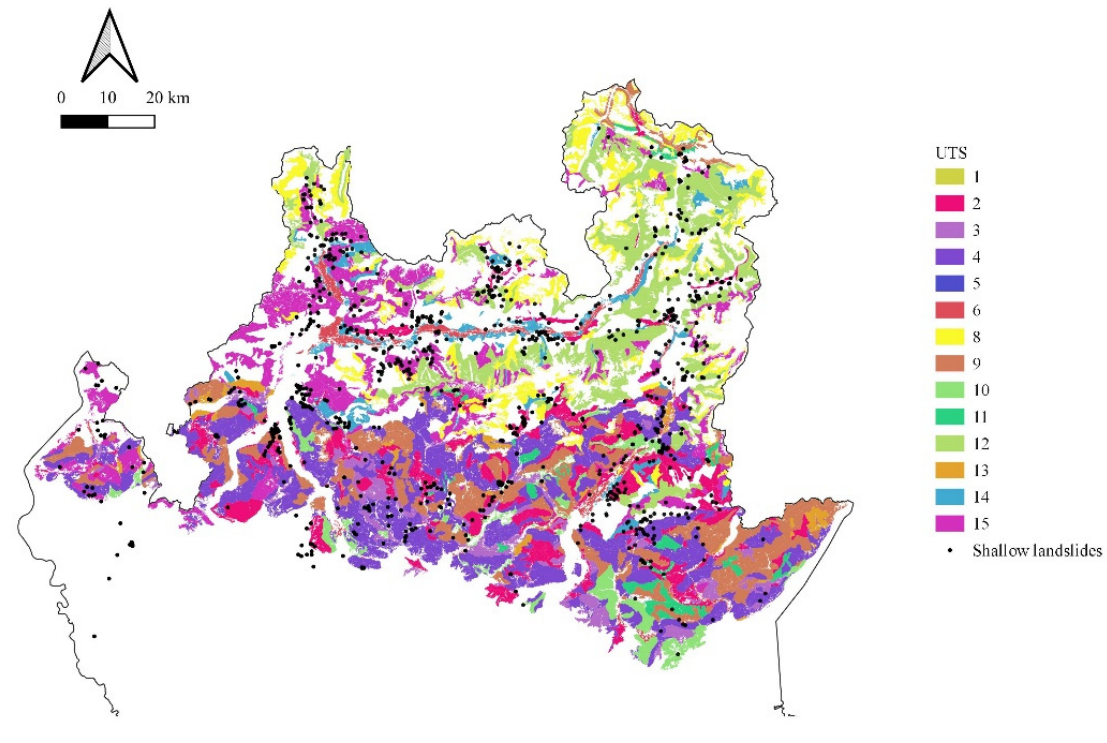
Figure 4. Map of the STU (soil typological unit) of the mountainous area of Lombardy (ref. scale